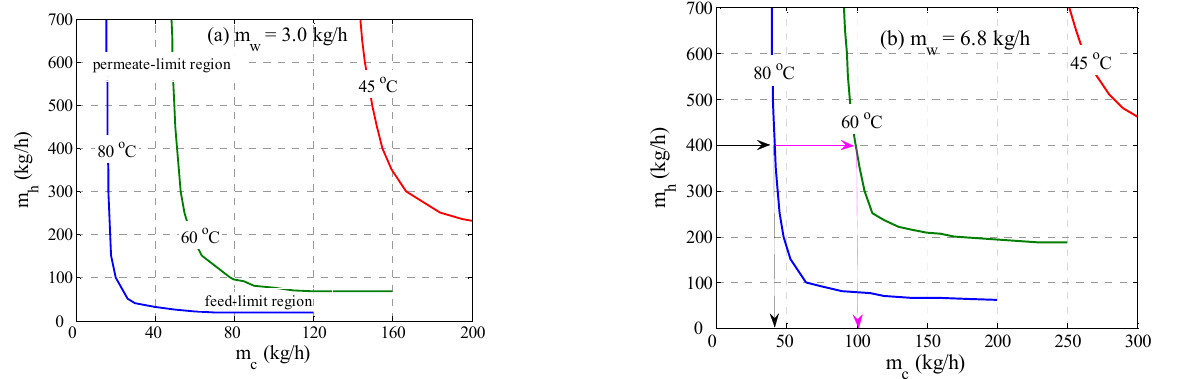
Figure 5. Operation range for different values for the inlet feed temperature.